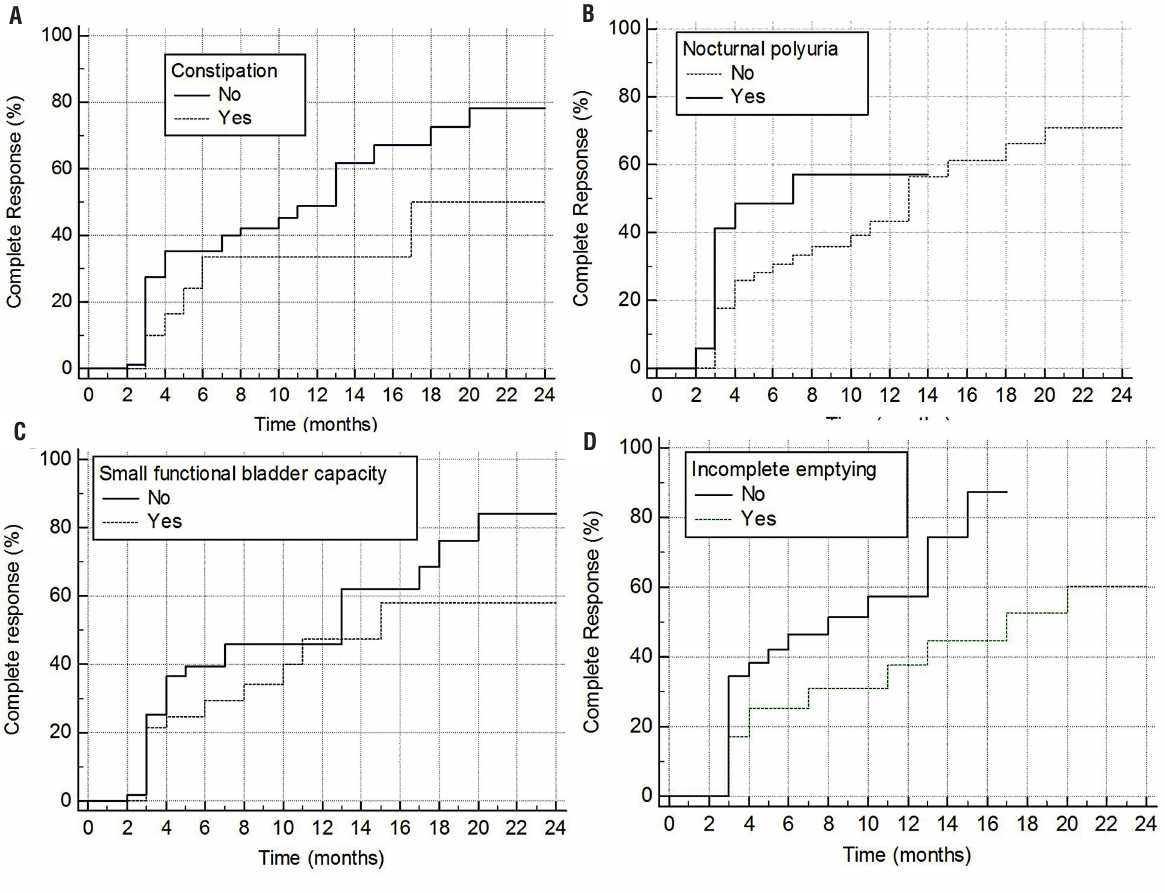
1.08, 95CI:0.54-2.15), nocturnal polyuria (HR: 1.71, 95CI: 0.71-4.14, Figure-1B), small functional bladder capacity (HR: 0.92, 95CI: 0.40-2.15, Figure-1C), ≥ 1 abnormal flow patterns (HR: 0.87, 95CI: 0.44-1.73) were not associated with complete response, while ≥ 1 elevated PVR (HR: 052 95CI:0.27-0.98, p=0.03,